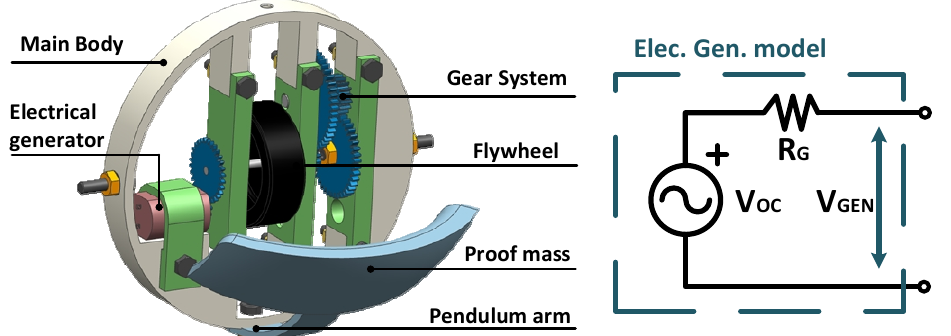
Figure 2. WEC transducer with the description of its main components ( left , [7]) and its electrical model ( right ).